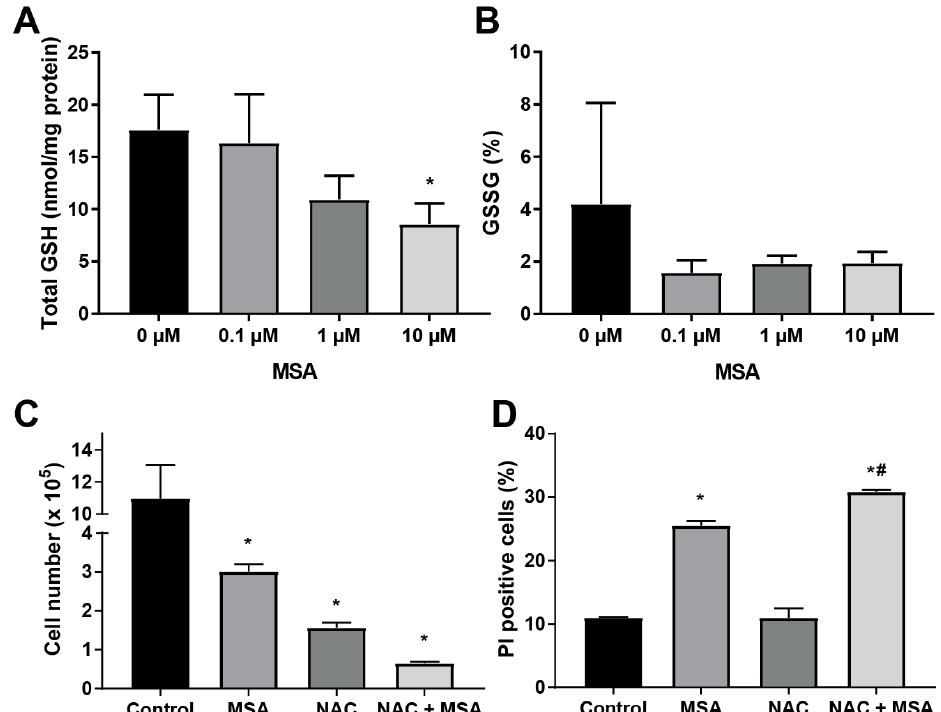
Figure 4. MSA exhibits toxicity in a glutathione (GSH)-dependent manner. ( A ) Total GSH in Cal27 cells treated with 0 to 10 µ M MSA for 72 h. ( B ) Percent of GSH existing as glutathione disulfide (GSSG) in Cal27 cells treated with 0 to 10 µ M MSA for 72 h. ( C ) Cell counts of Cal27 cells following treatment with 5 mM N -Acetyl- L -Cysteine (NAC) for 24 h, and/or 10 µ M MSA for 72 h. The NAC + MSA group received 5 mM NAC for 24 h before treatment with MSA. ( D ) PI exclusion assay of Cal27 cells treated with 5 mM NAC for 24 h, and/or 10 µ M MSA for 72 h. The NAC + MSA group received 5 mM NAC for 24 h before treatment with MSA. *, statistical significance relative to 0 µ M MSA controls; #, statistical significance relative to NAC alone; p < 0.05, n = 3.